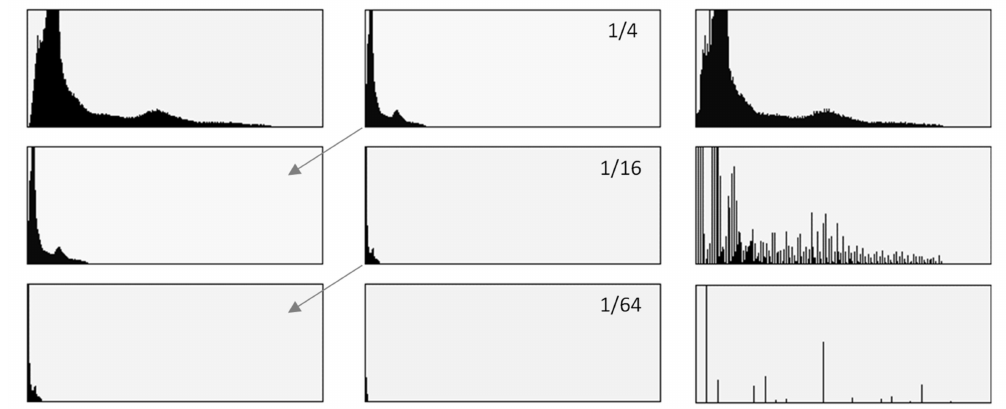
Figure 8. Sample image histograms for simplified static experiments outlined in Figure 4: for the original UV light image (top left), after brightness reduction to 1/4, 1/16, and 1/64 (middle column), and after histogram correction (right column). Despite huge differences between the corrected histograms, the output images in Table 3 seem very similar to each